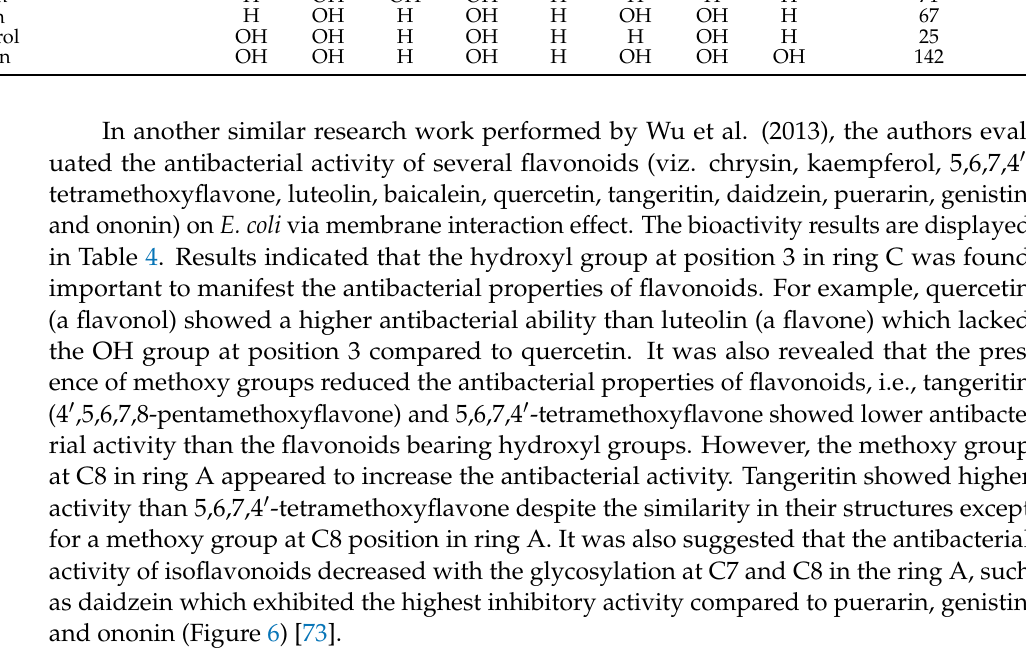
Table 4. Antibacterial activity of several flavones and isoflavones against E. coli via membrane in- teraction effect.